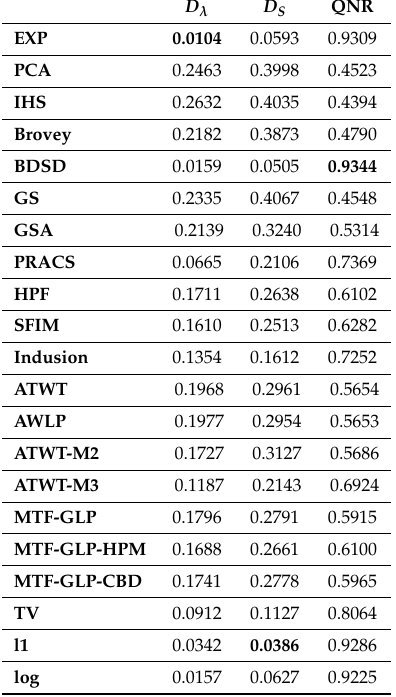
Table 7. QNR quantitative results on the LANDSAT 7-ETM+ Netherland image in Figure 2a. Bold values indicate the best